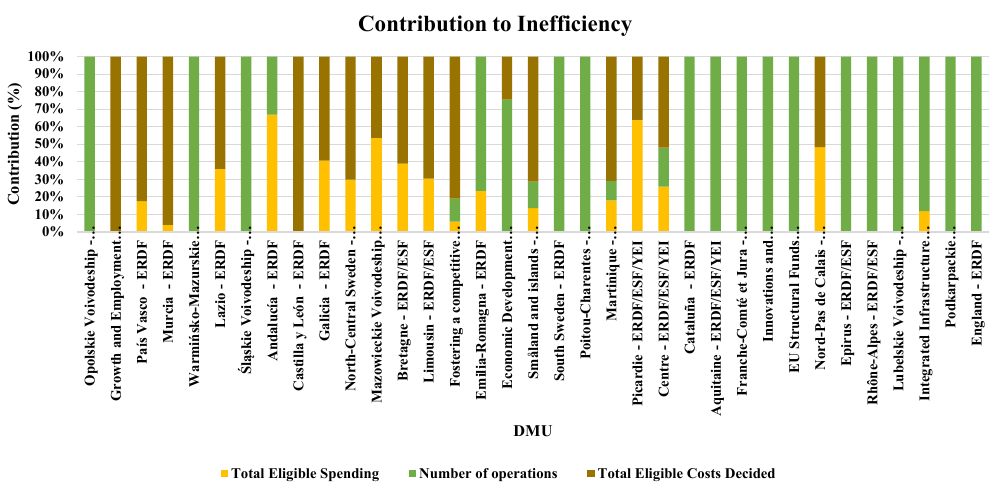
Figure 10. Contribution of inputs and outputs to inefficiency.